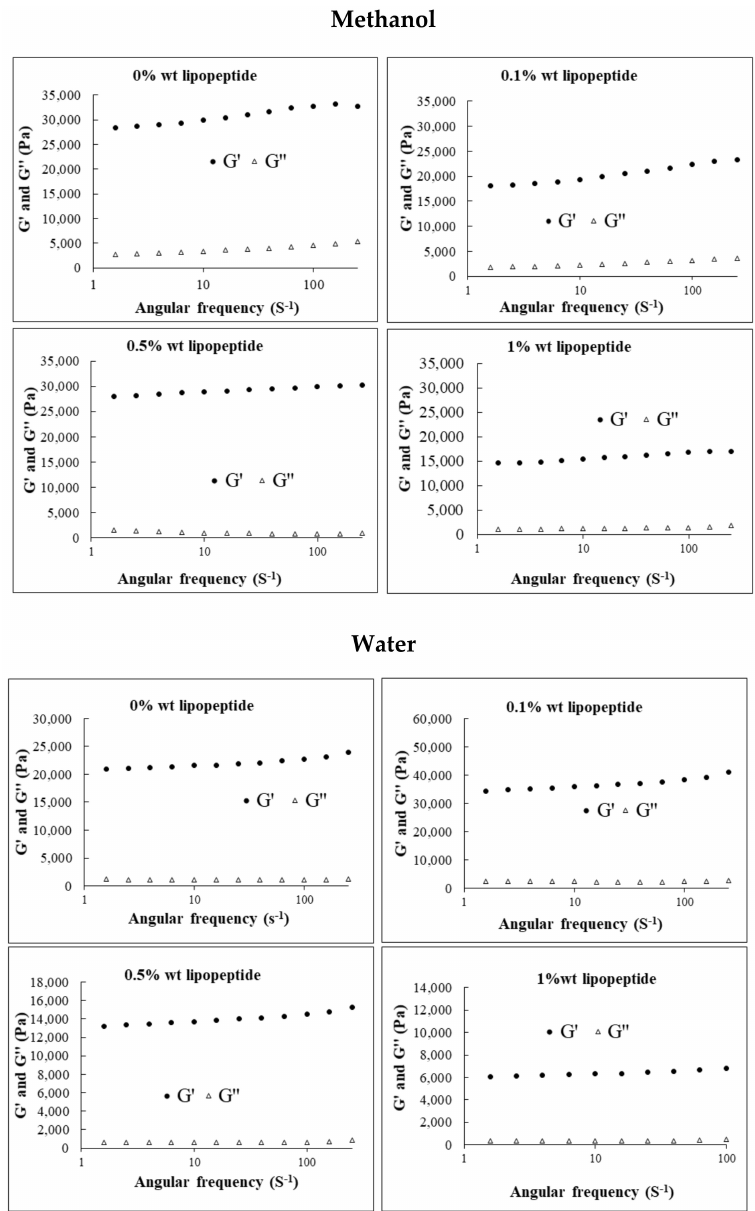
Figure 1. Storage (G (cid:48) , closed circle) and loss (G (cid:48)(cid:48) , open triangle) moduli of the gel samples containing di ff erent concentrations of the lipopeptide prepared in methanol ( top four graphs) and water ( bottom four